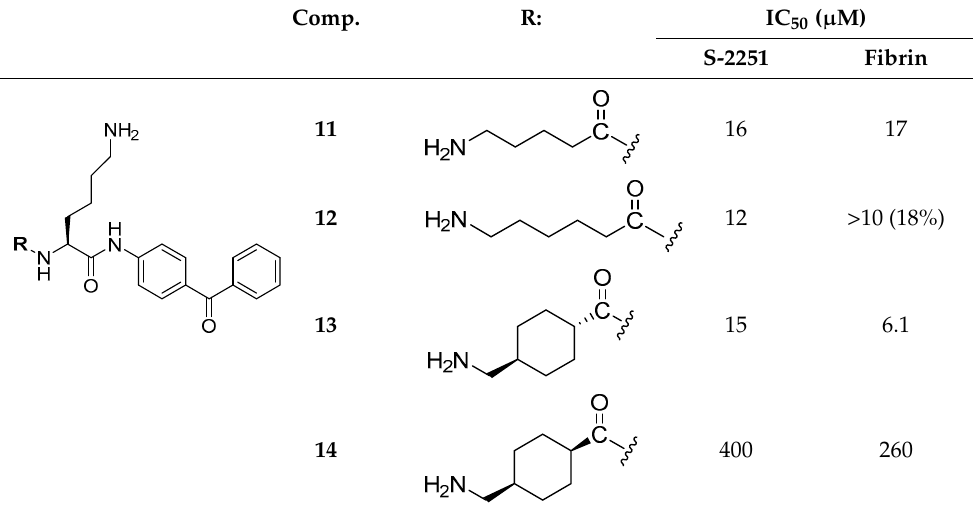
Table 3. Plm inhibitory activity of compounds 11–14 [29]. Comp.